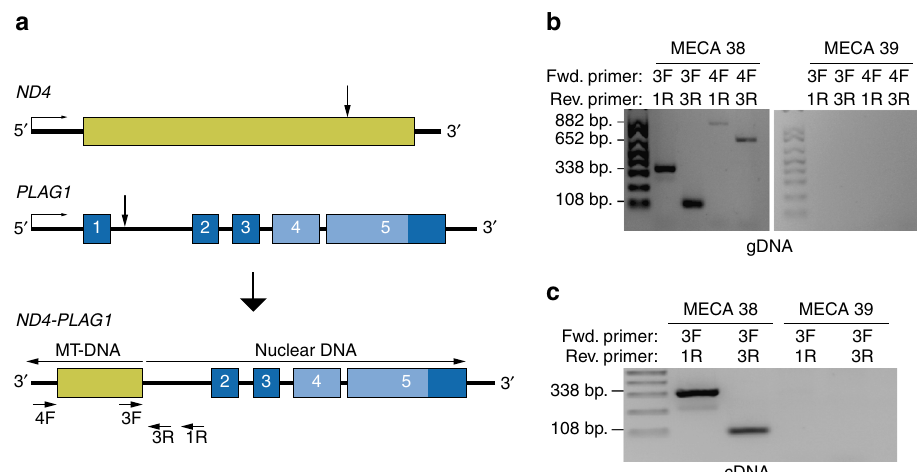
Fig. 4 Detection of the novel mitochondrial/genomic DNA fusion gene ND4-PLAG1 . a Illustration of ND4-PLAG1 . MT mitochondrial. b PCRs of genomic DNA extracted from the ND4-PLAG1 -positive tumor (case 38) and a fusion-negative tumor (case 39), using the denoted primer pairs. Of the 882 bp PCR product of primers 4F and 1R, 591 bp are mitochondrial and 291 bp are nuclear DNA. c PCRs of cDNA extracted from tumor 38 and